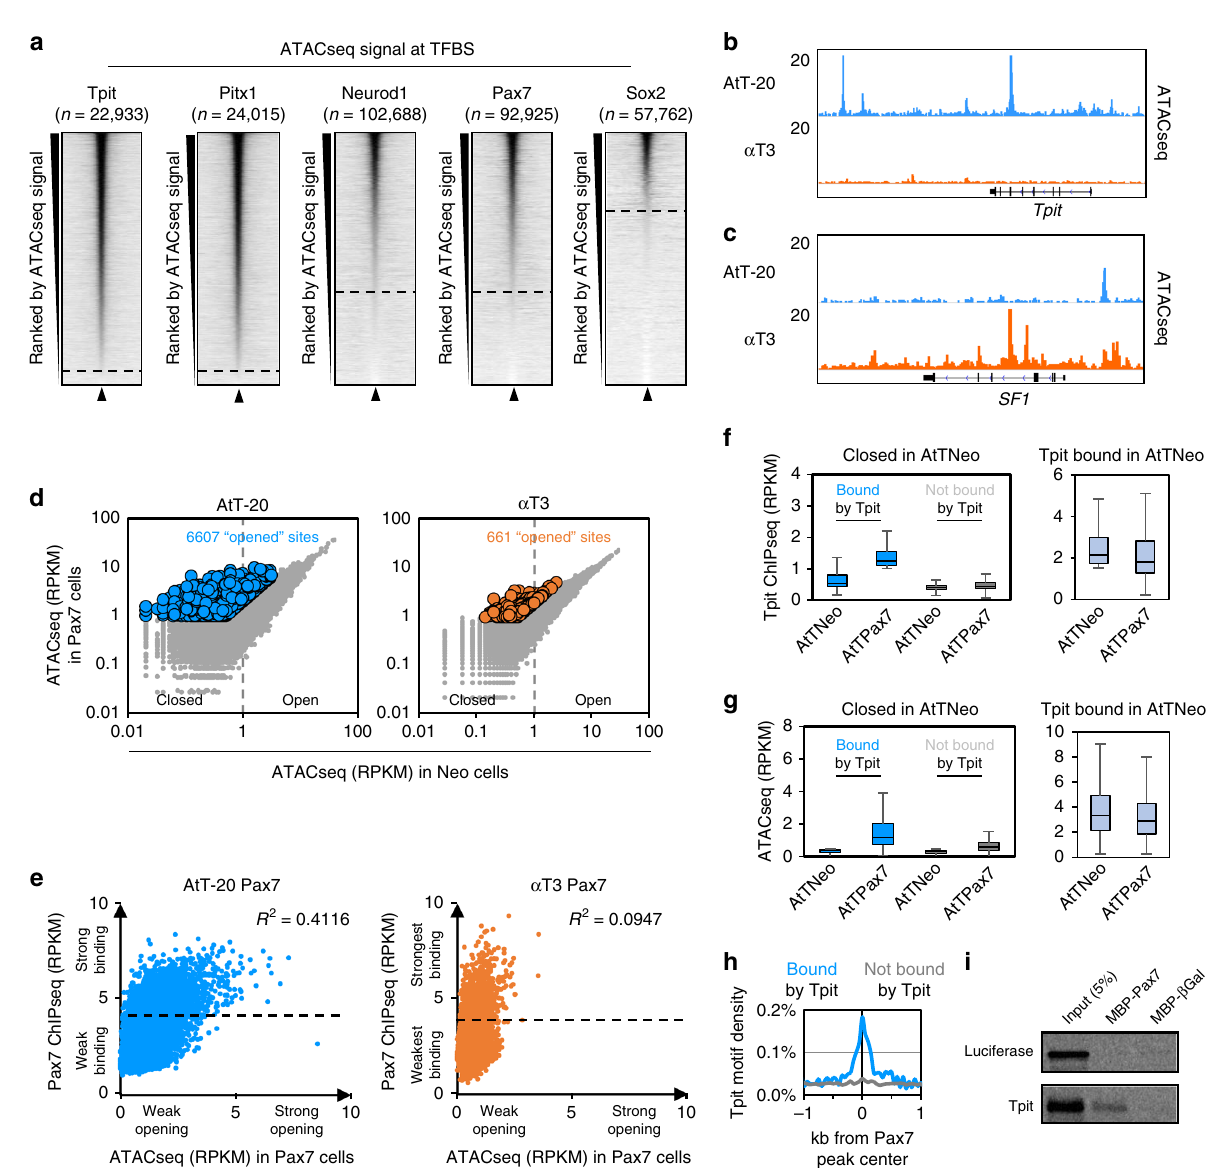
Fig. 6 Pax7 binding on closed chromatin is only productive in Tpit-expressing cells. a Read density heatmaps of assay for transposase-accessible chromatin using sequencing (ATACseq) signal density in a 4 kb window centered on binding sites for the indicated factors. The heatmaps are ranked by their decreasing ATACseq central (200 bp) read densities. b , c Genome browser views of ATACseq pro fi les in AtT-20 and α T3 cells at the Tpit ( b ) and SF1 ( c ) loci. d Dispersion plots of central (200 bp) ATACseq read densities in Neo ( x -axis) versus Pax7 ( y -axis) expressing AtT-20 (left) and α T3 cells (right) at all Pax7 binding sites in the indicated cell lines. Colored dots represent sites with signi fi cantly stronger signals after Pax7 expression. e Dispersion plots of ATACseq read densities in Pax7-expressing cells ( x -axis) over Pax7 chromatin immunoprecipitation sequencing (ChIPseq) read densities ( y -axis) in AtT- 20 (left) and α T3 cells (right) at Pax7 binding sites with no ATACseq signal (<1 reads per kilobase of transcript, per million mapped reads (RPKM) in Neo cells) before Pax7 expression. f , g Boxplots of Tpit ChIPseq ( f ) and ATACseq ( g ) read densities in Neo- and Pax7-expressing AtT-20 cells at Pax7 sites without ATACseq signal (<1 RPKM in Neo cells) before Pax7 expression subdivided into Tpit-bound (>1 RPKM in Pax7-expressing cells, blue) and not bound by Tpit (<1 RPKM in Pax7-expressing cells, gray). Right panels: in light blue, Tpit binding and ATACseq signals are shown at sites bound by Tpit before Pax7 expression, that is, at open chromatin sites (without fi ltering the initial ATAC signal). Center lines show medians; box limits indicate the 25th and 75th percentiles; whiskers extend to 1.5 times the interquartile range from the 25th to 75th percentiles. h Tpit motif density at Pax7 sites without ATACseq signal before Pax7 expression subdivided into Tpit-bound (>1 RPKM in Pax7-expressing cells, blue) and not bound by Tpit (<1 RPKM in Pax7- expressing cells, gray). i Pull-down assay of in vitro translated Tpit interaction with MBP-Pax7, but not with MBP- β while other α T3-speci fi c sites (the <20 kb distant sites) are enriched for binding sites of the gonadotrope-speci fi c TFs SF1 and NeuroG2 (Supplementary Fig. 6d, e). Restrictions to Pax7 binding in different lineages thus appear to include chromatin status and/or presence of binding sites for lineage-restricted factors as previously shown for other pioneers 22,23 .